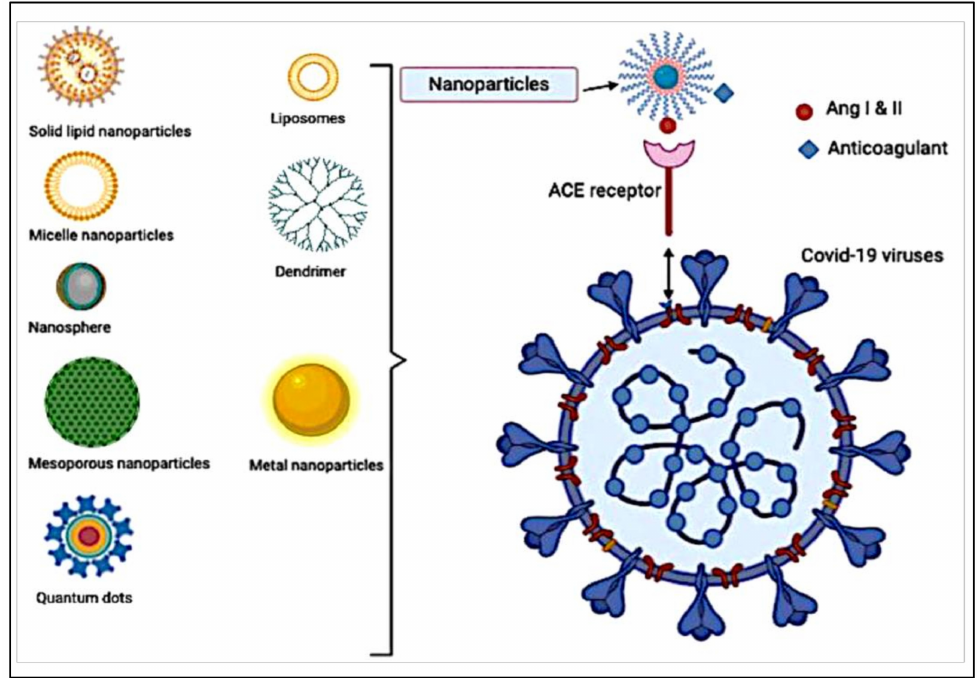
Figure 2. Schematic diagram representing the different formulated nanoparticles coated with antico- agulant for targeting ang I and II